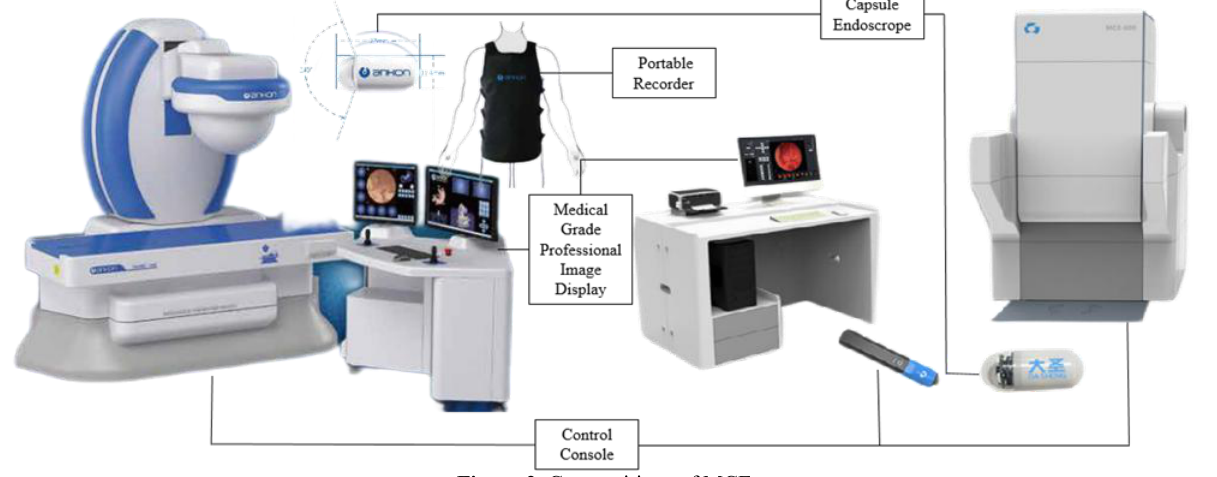
Figure 2. Compositions of MCE